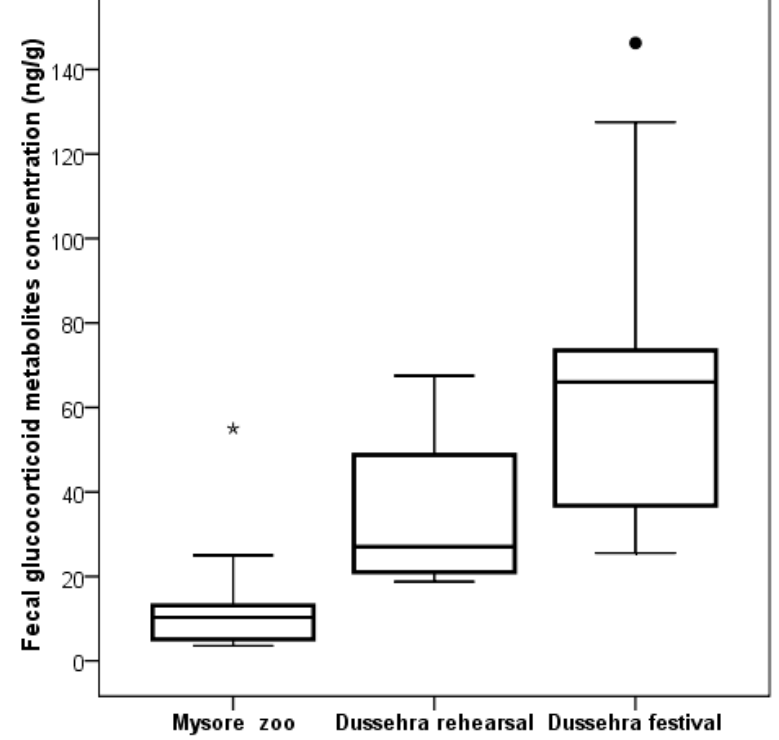
Figure 3. fGCM concentration of elephants from Mysore zoo, Dusshera rehearsal, and the Dussehera festival day. fGCM values in facilities were significantly different ( p = 0.01). (Filled rounds = outliers, filled asterisk = extreme values).